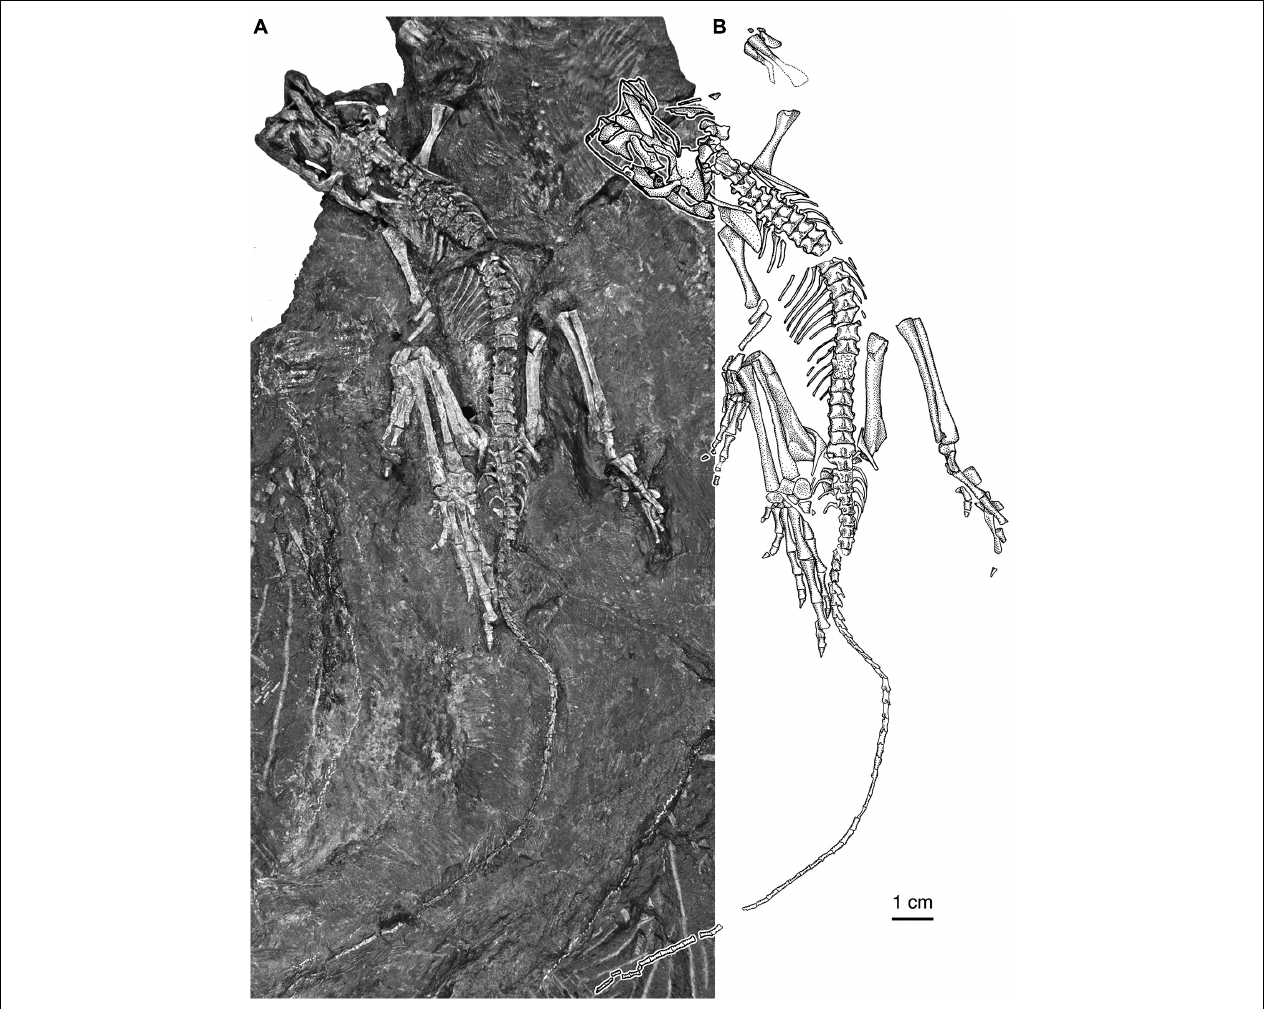
FIGURE 1 | Eudibamus cursoris , holotype (MNG 8852). Essentially complete skeleton exposed mainly in dorsal view. (A) Photograph and (B) illustration (modified after Berman et al.,